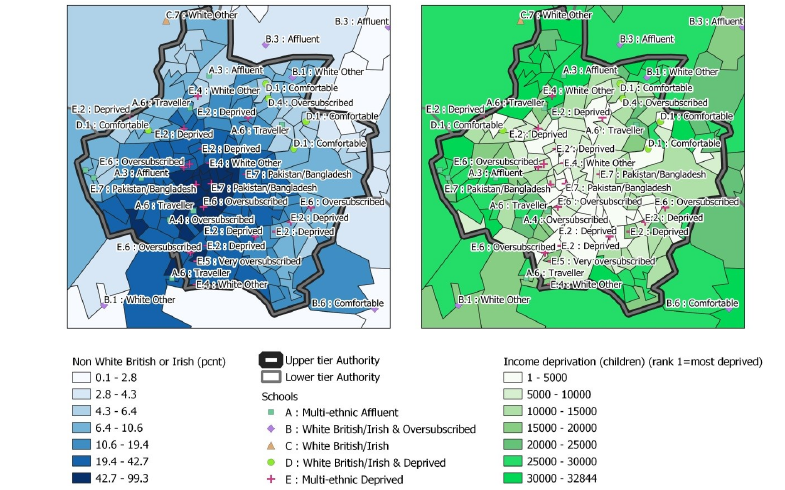
Figure 4: Categorisation of schools in